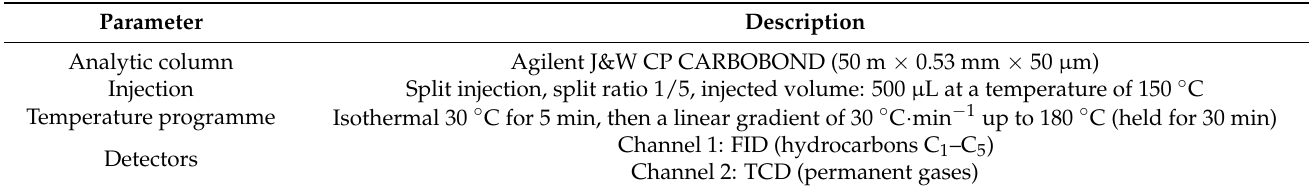
Table 16. The conditions of the chromatographic analysis of the gaseous products. Parameter